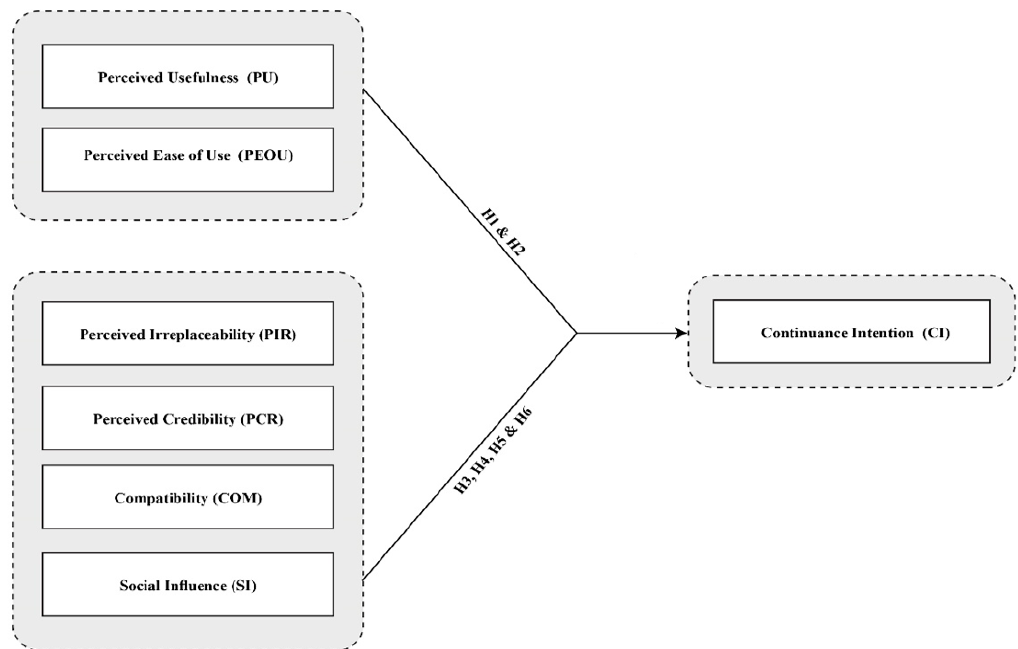
Figure 1. Conceptual Model of CI (Source: Authors’ research).